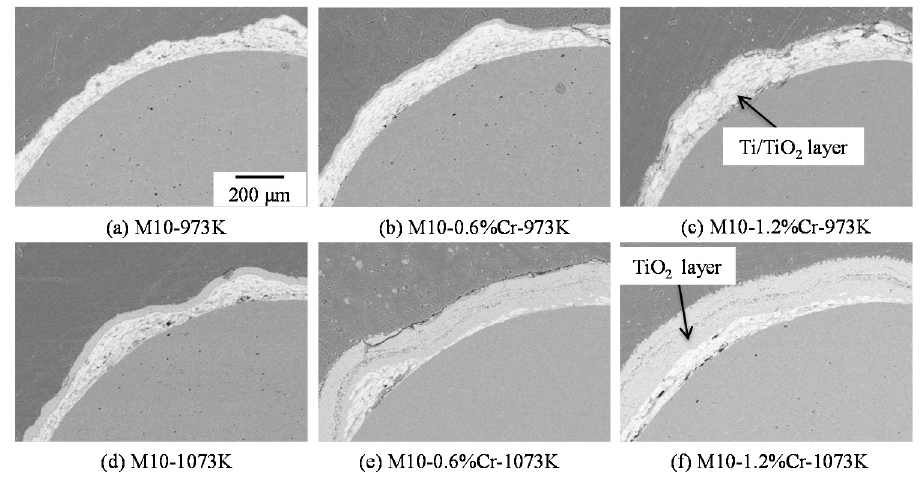
Figure 52. SEM images of cross sections of M10- x Cr- y K samples.